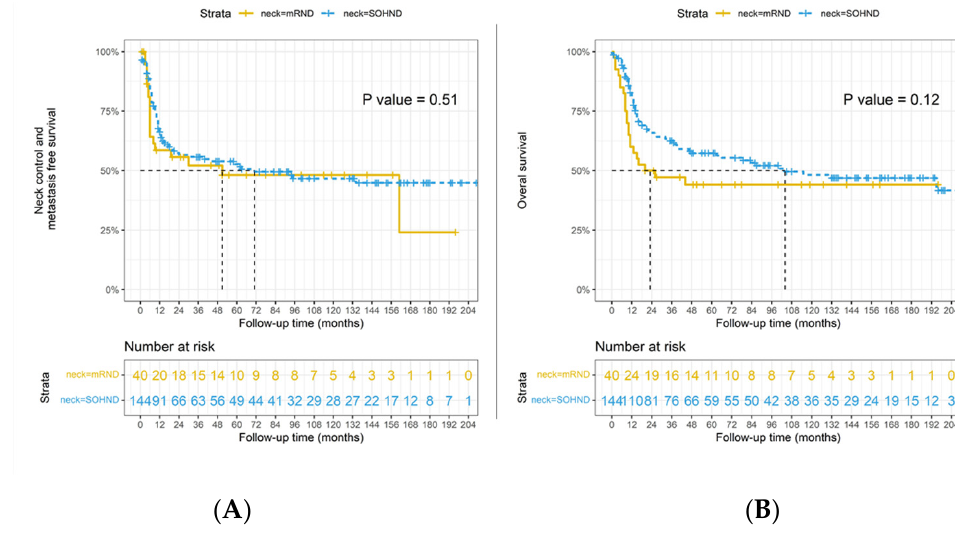
Figure 1. ( A ) Disease-free survival differences in pN+ patients by types of neck dissection ( n = 184, p = 0.51); ( B ) overall survival differences in pN+ patients by types of neck dissection ( p = 0.12). Dotted line indicated the survival time that half of the patients had no events.